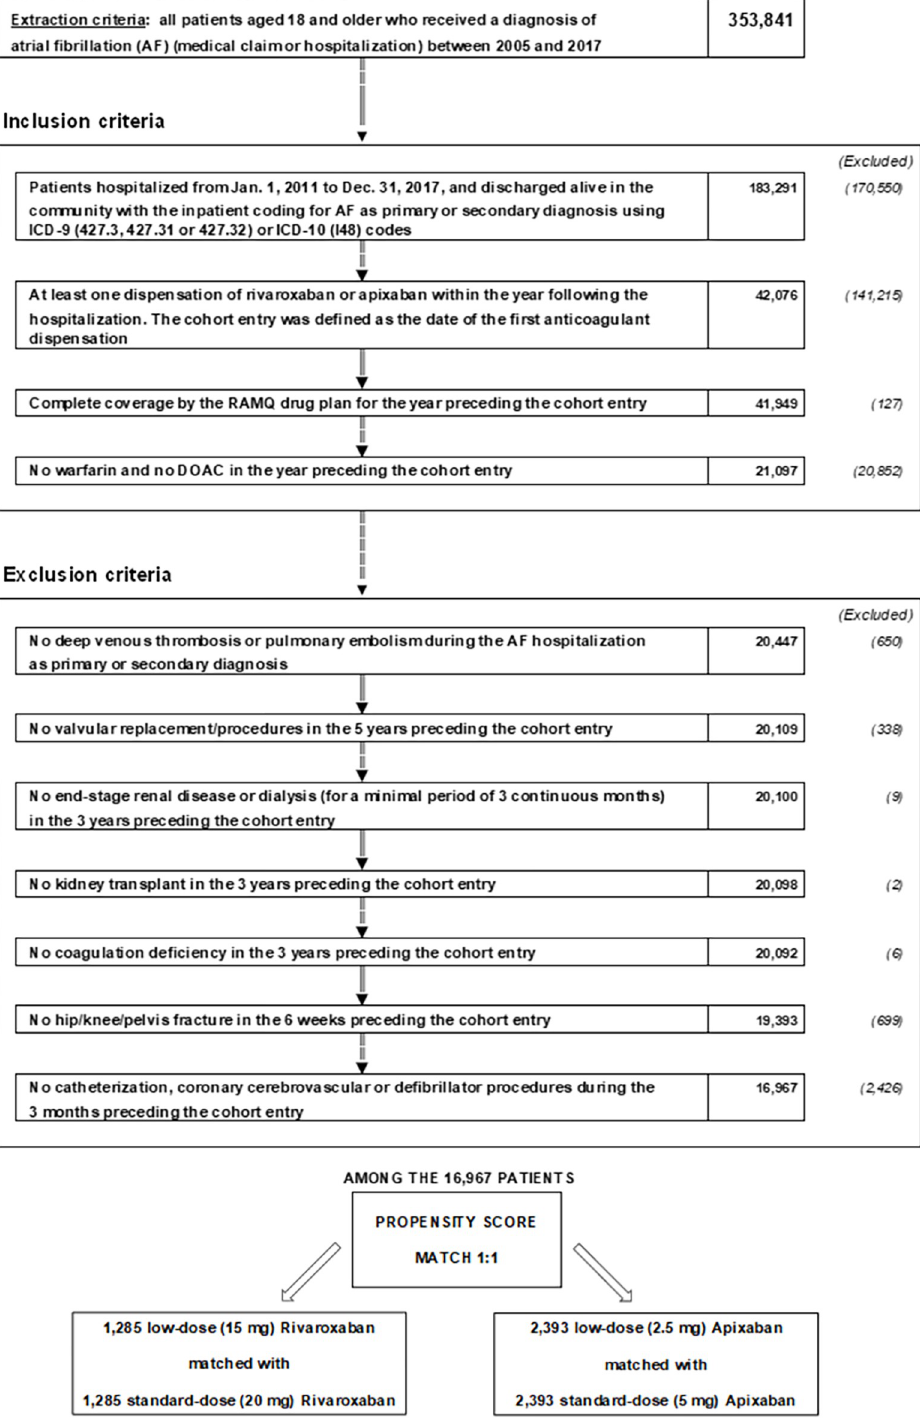
PLOS ONE | https://doi.org/10.1371/journal.pone.0277744 December1,